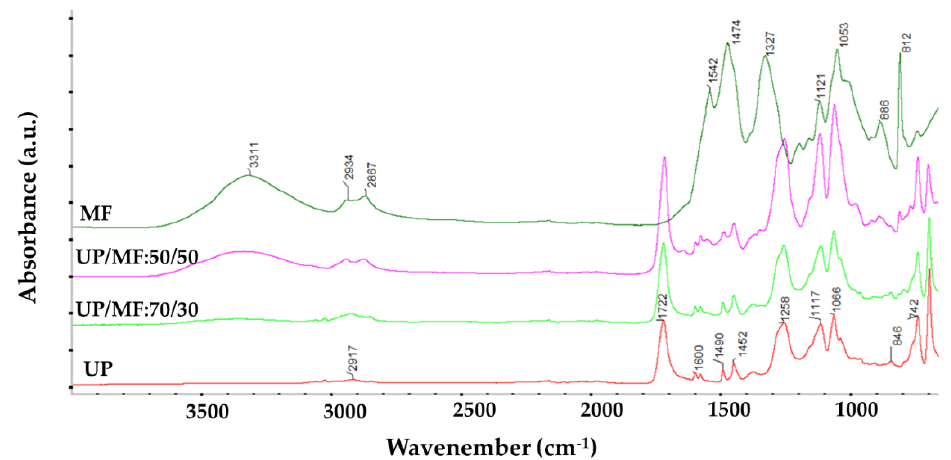
Figure 2. IR-ATR spectra of UP, UP/MF:70/30, UP/MF:50/50, and MF cured cast resins.